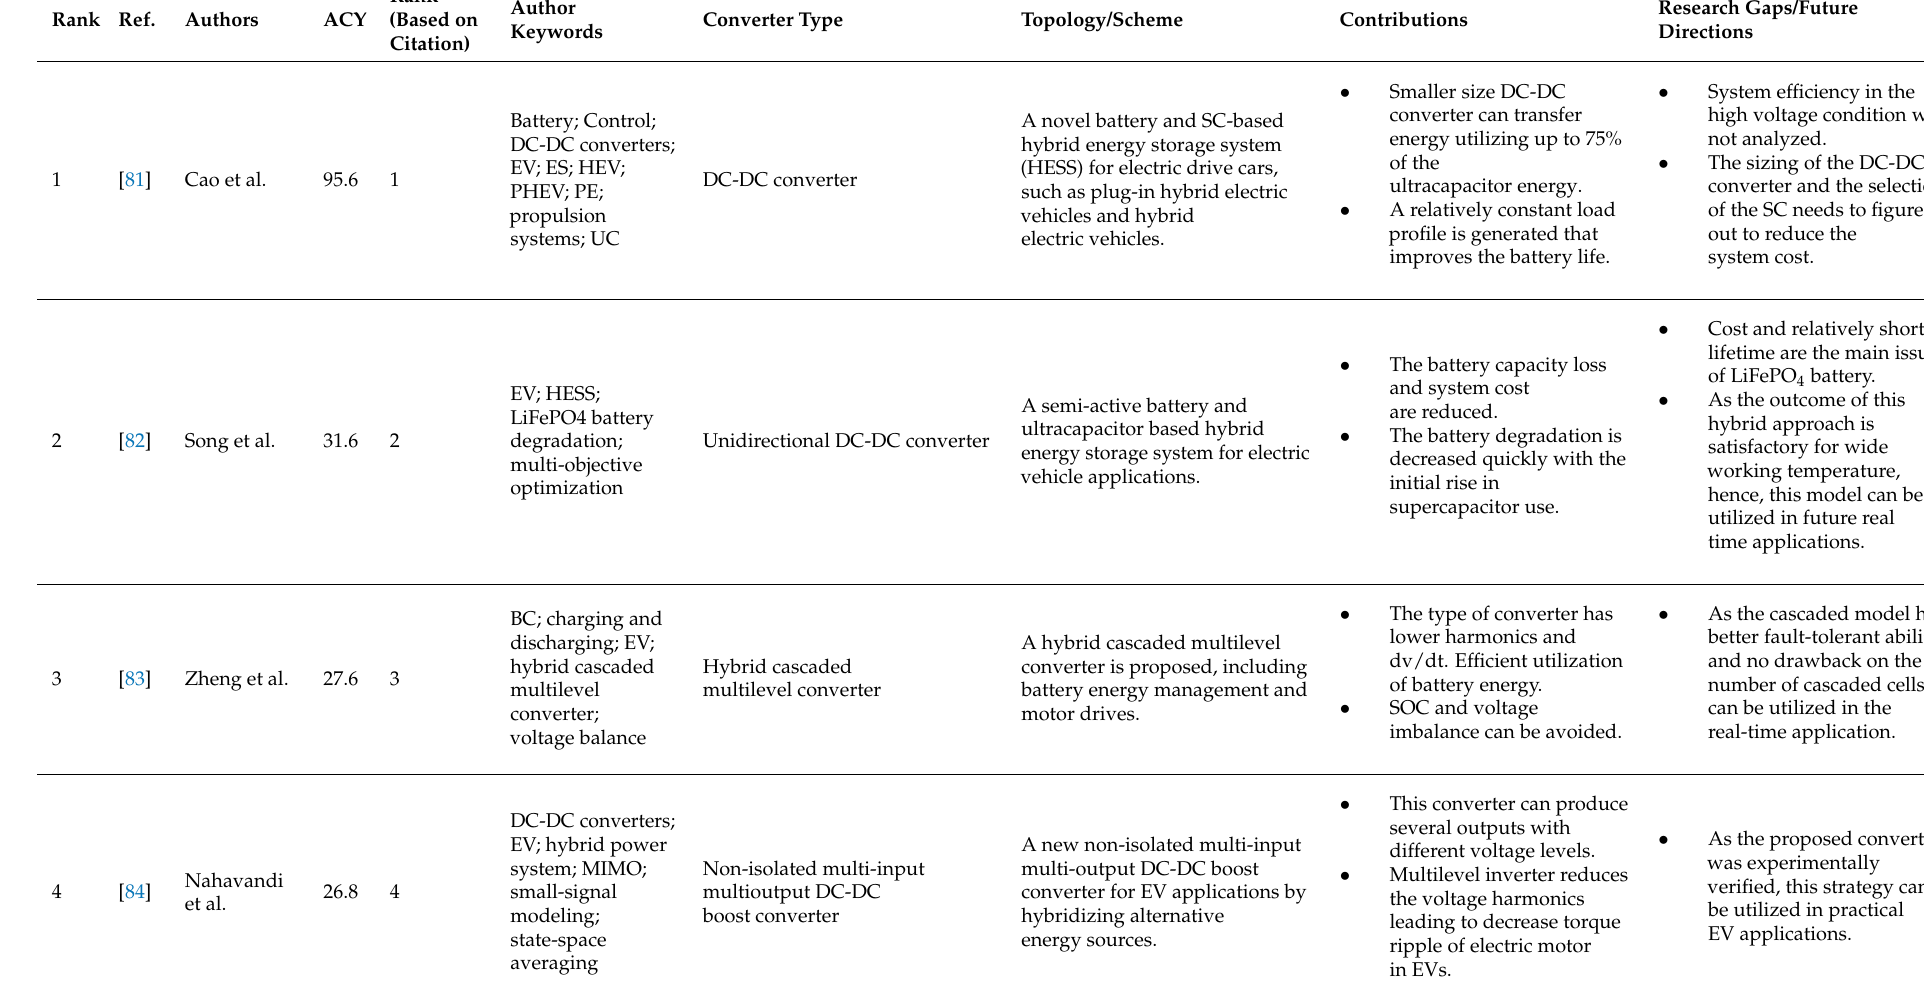
Table 8. “Average citation per year (ACY)” of top 10 articles and their schemes, contributions, and research gaps. Rank